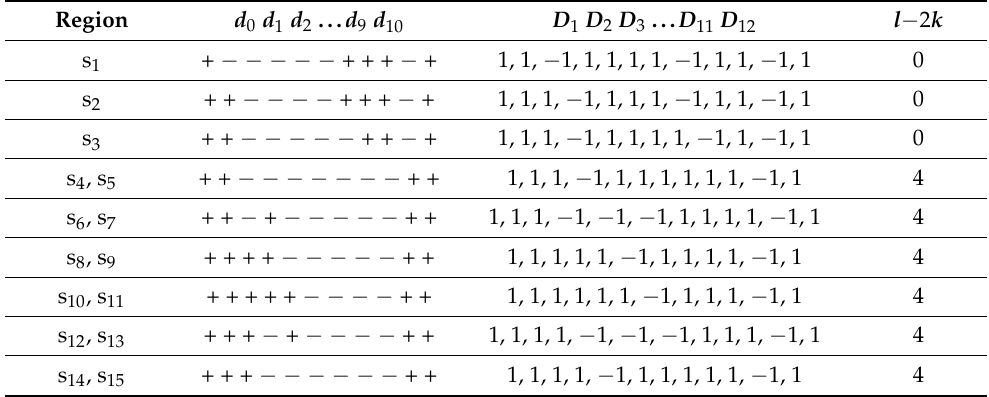
Table 4. Sign tables of the discrimination sequence of the polynomial. Region d 0 d 1 d 2 ... d 9 d